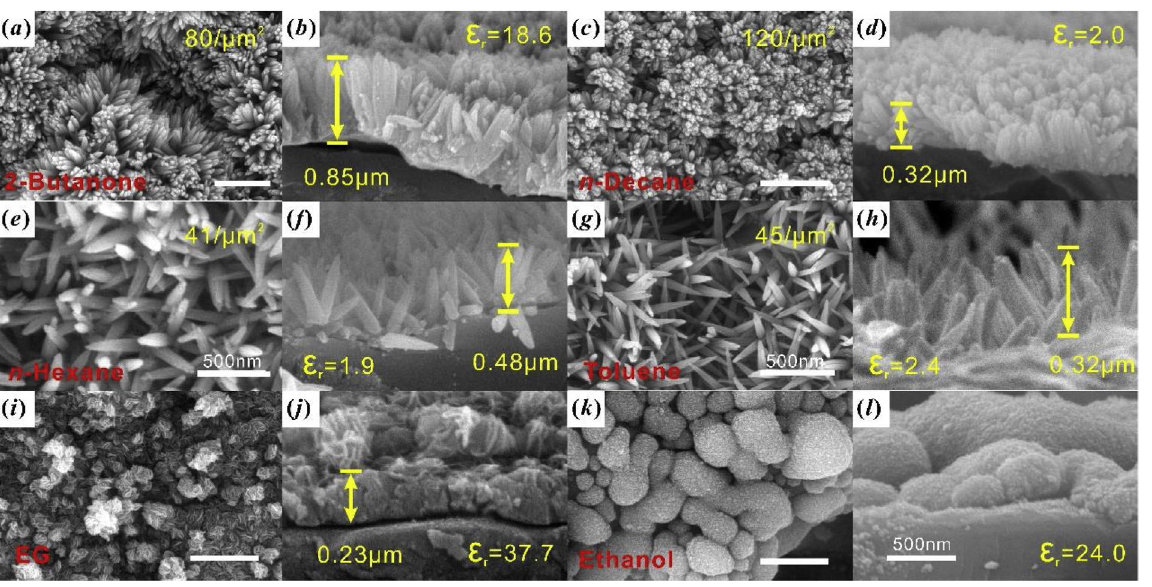
Figure 24. Comparative SEM analysis of TiO 2 nanostructures using various organic solvents: ( a , b ) 2 -butanone, ( c , d ) n -decane, ( e , f ) n -hexane, ( g , h ) toluene, ( i , j ) ethylene glycol, and ( k , l ) ethanol. Reprinted from [96].